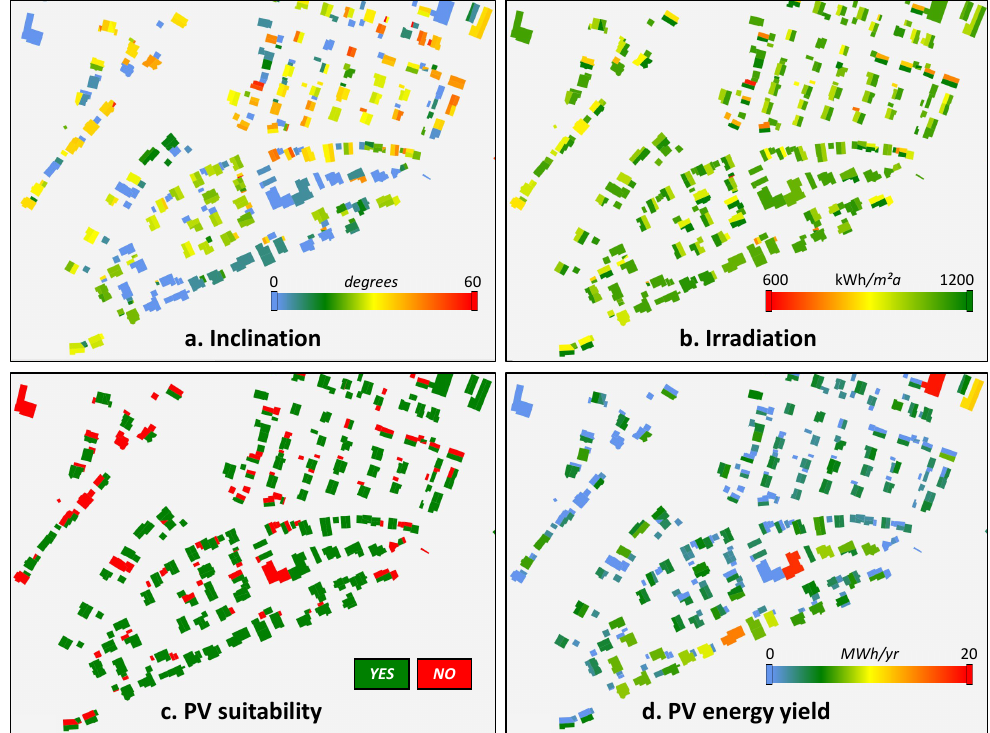
Figure 7. Examples of the simulation results for PV electricity generation in SimStadt for a part of